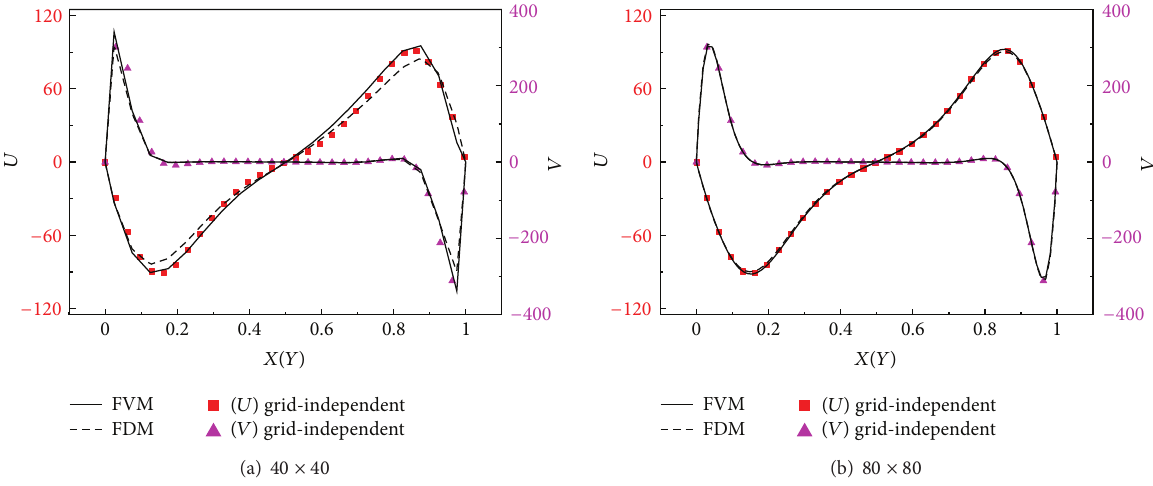
Figure 6: Velocity along the central axis of convection flow in a square cavity with variant gird densities.